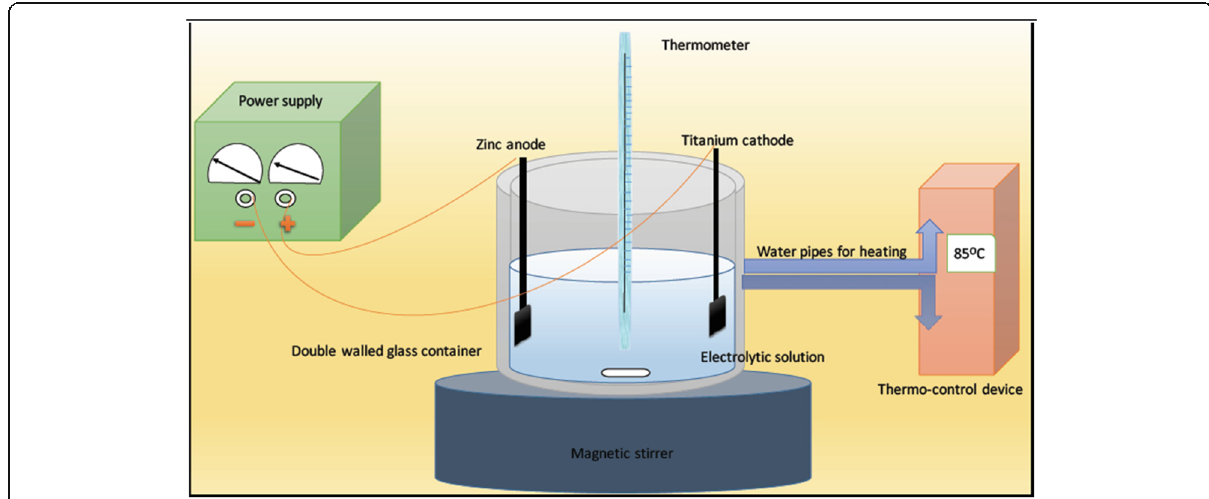
Fig. 1 Graphical presentation of the electrochemical-deposition coating process ’ equipment